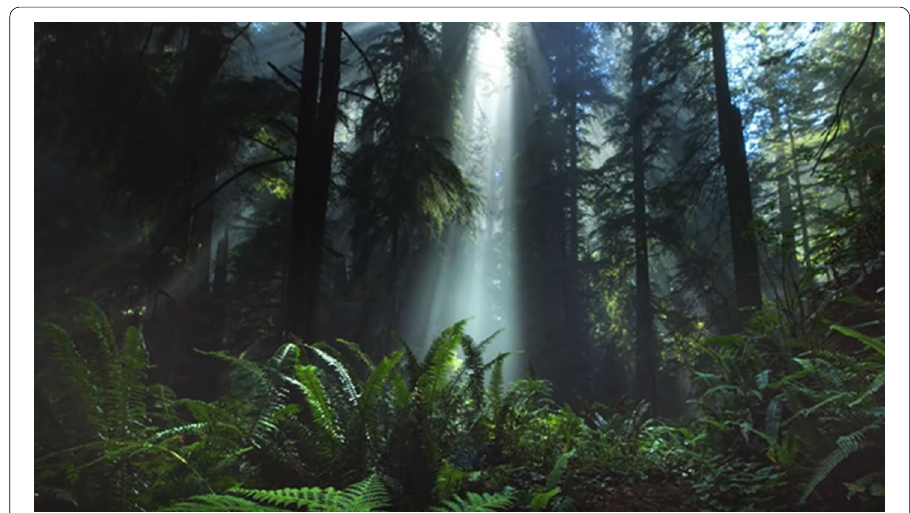
Fig. 1 Screenshot of the Meditation